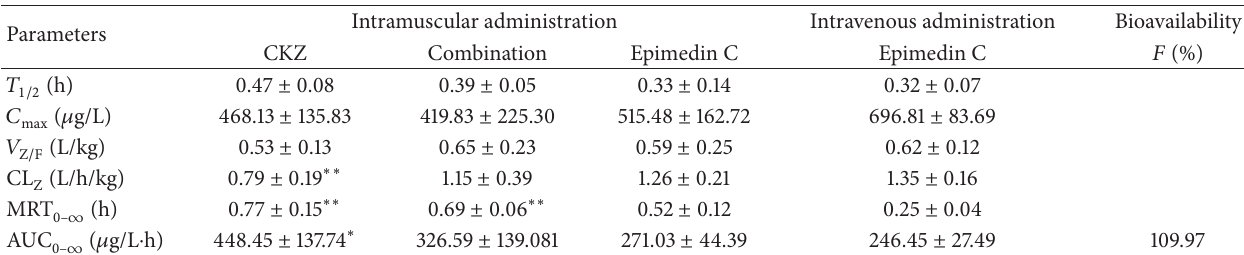
Table 3: The pharmacokinetic parameters of epimedin C after intramuscular administration of epimedin C, combination of four flavonoid glycosides, and CKZ at the epimedin C dose of 0.33 mg/kg ( 𝑛 = 6 ).